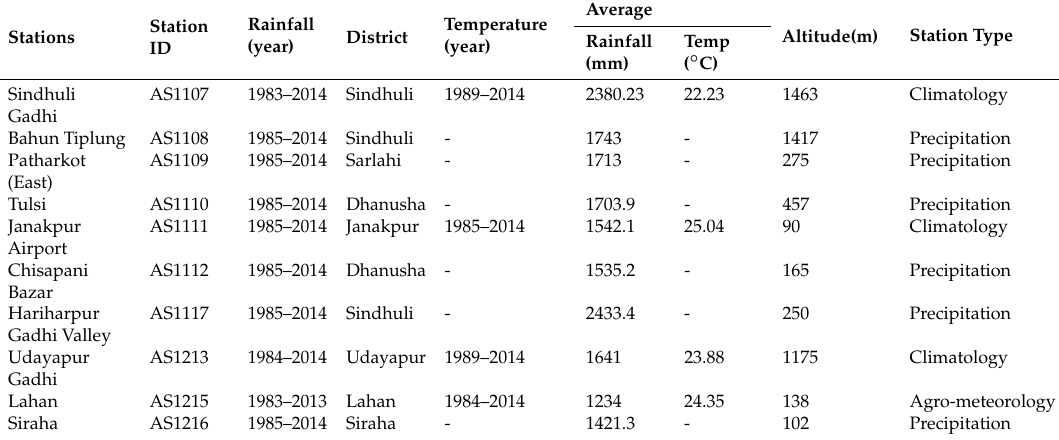
Table 2. List of precipitation and temperature stations along the Kamala